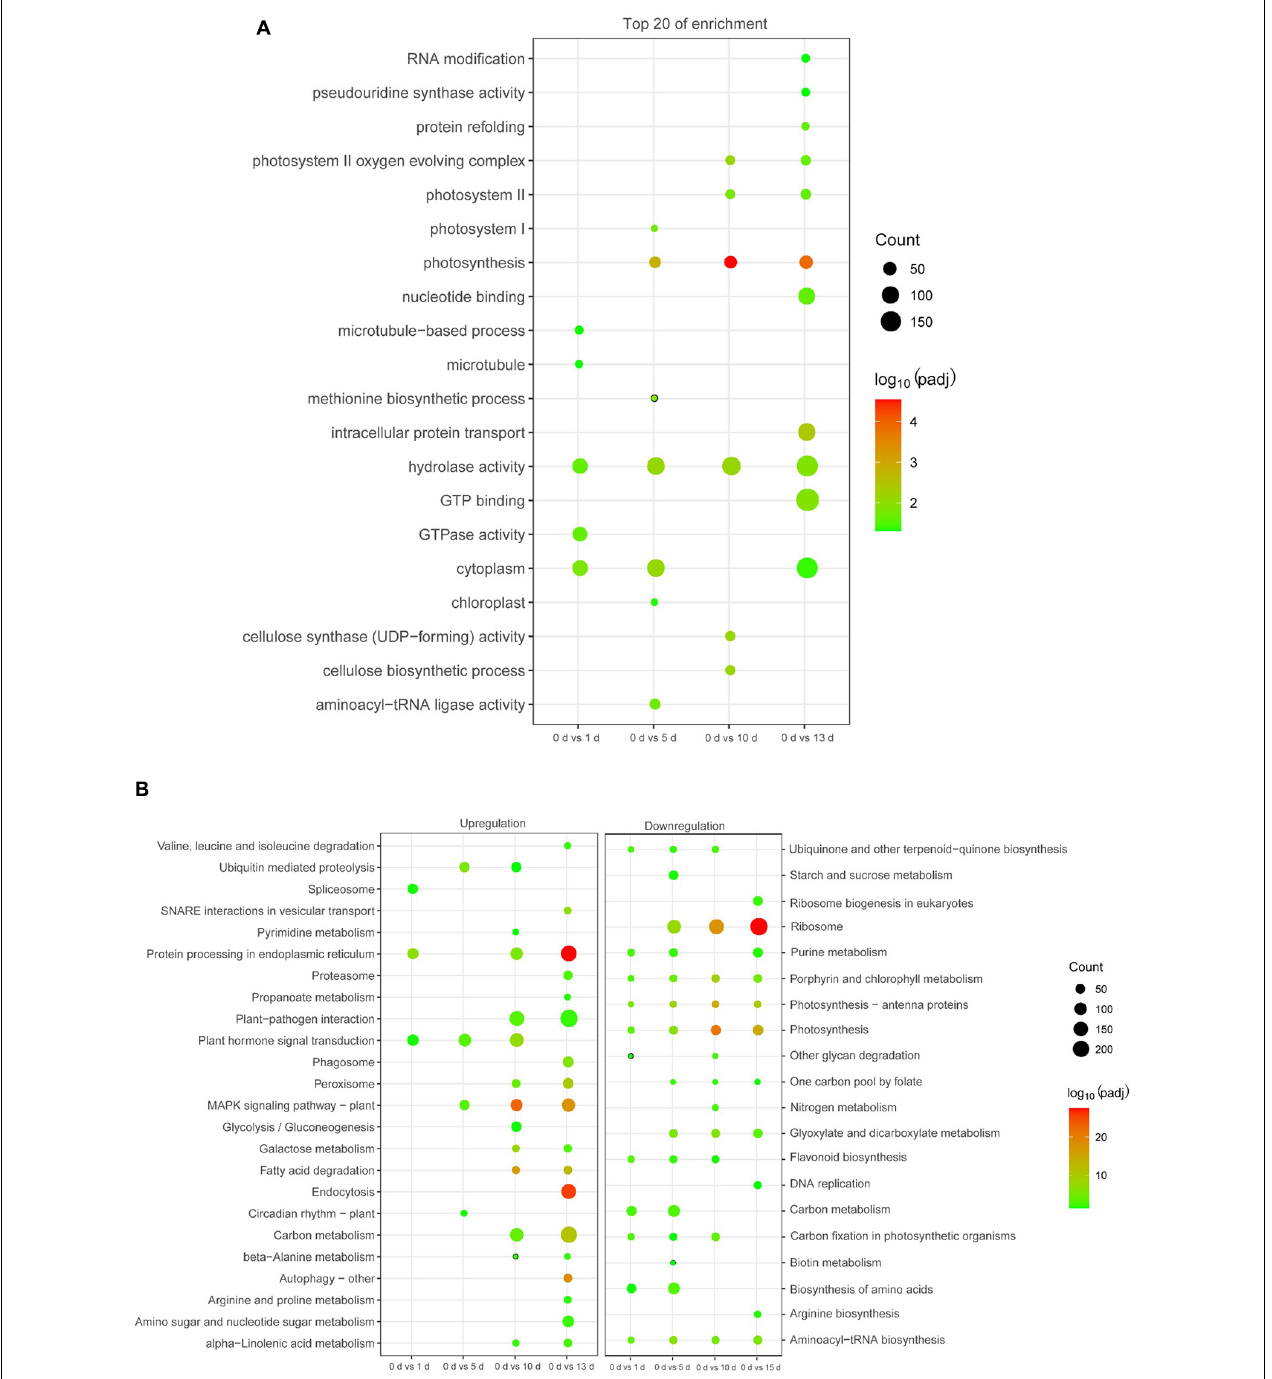
FIGURE 3 | Function enrichment analysis of DEGs in date palm respond to high salinity. (A) Gene Ontology (GO) enrichment analysis for the DEGs. (B) Kyoto Encyclopedia of Genes and Genomics (KEGG) pathway analysis for the